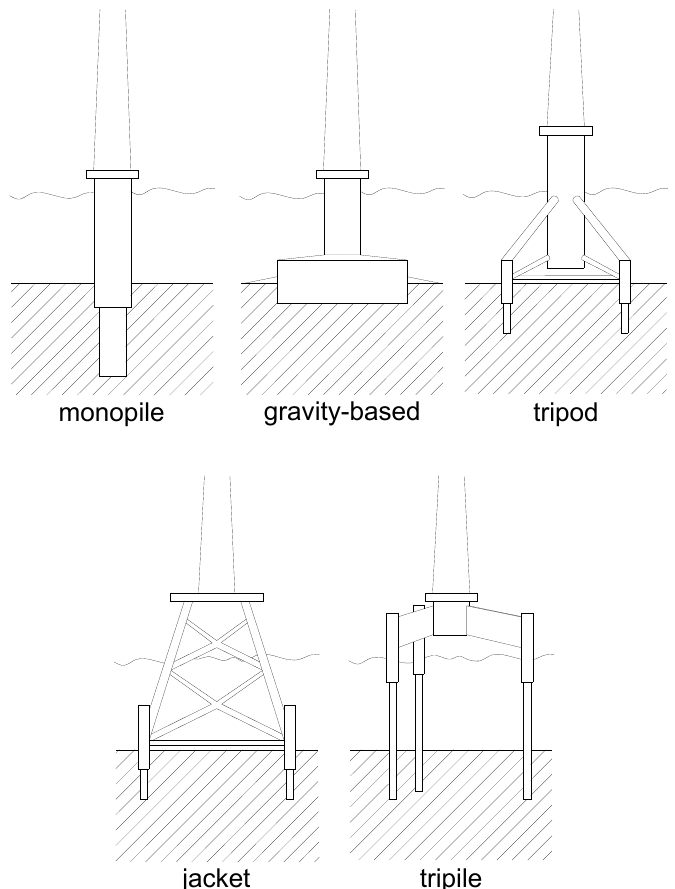
Figure 1. Technological environment and methods used for offshore wind farm anchoring. Authors’ own work.